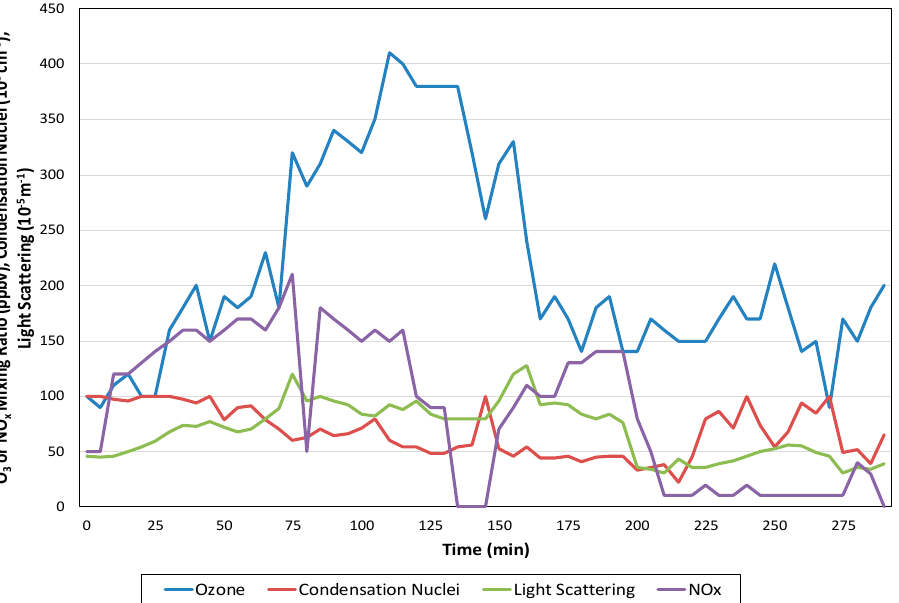
Figure 9. Lagrangian-like northwest to west trajectory observations from the blimp midday flight, September 6, 1973. The portion following air mass movement analogous to smog chamber O 3 and particulate profiles is 0–165 min. The smog-chamber-like time series began and ended near Torrance, CA (US) [247] (reprinted with permission of the Air and Waste Management Association, www.awma.org).